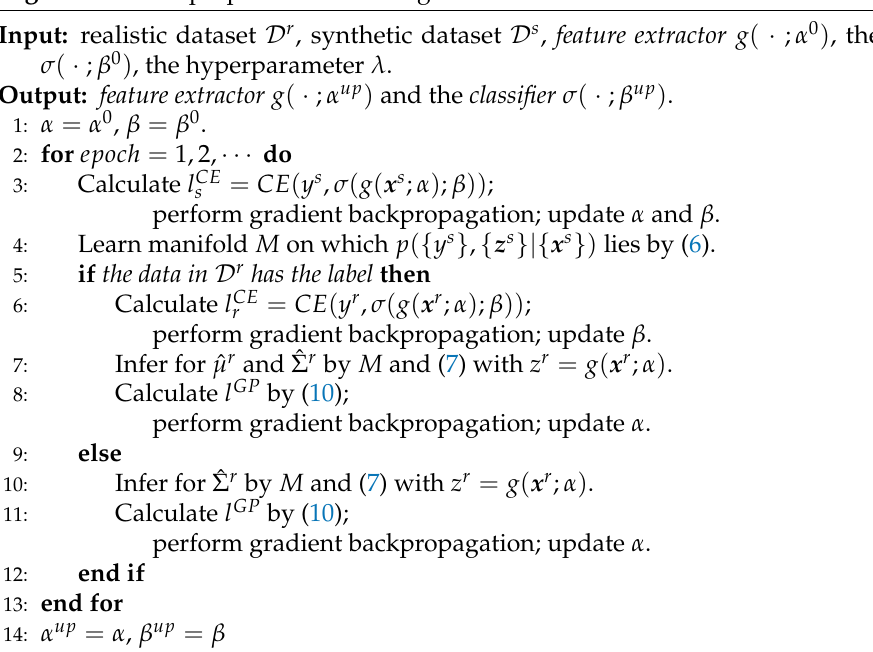
Algorithm 1 The proposed GPGDA